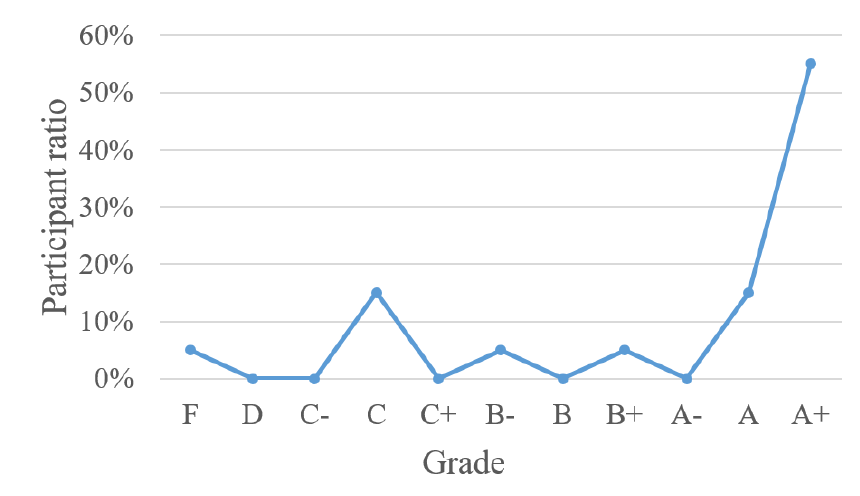
Figure 11. Curved classification scale of the score obtained from the SUS questionnaire.